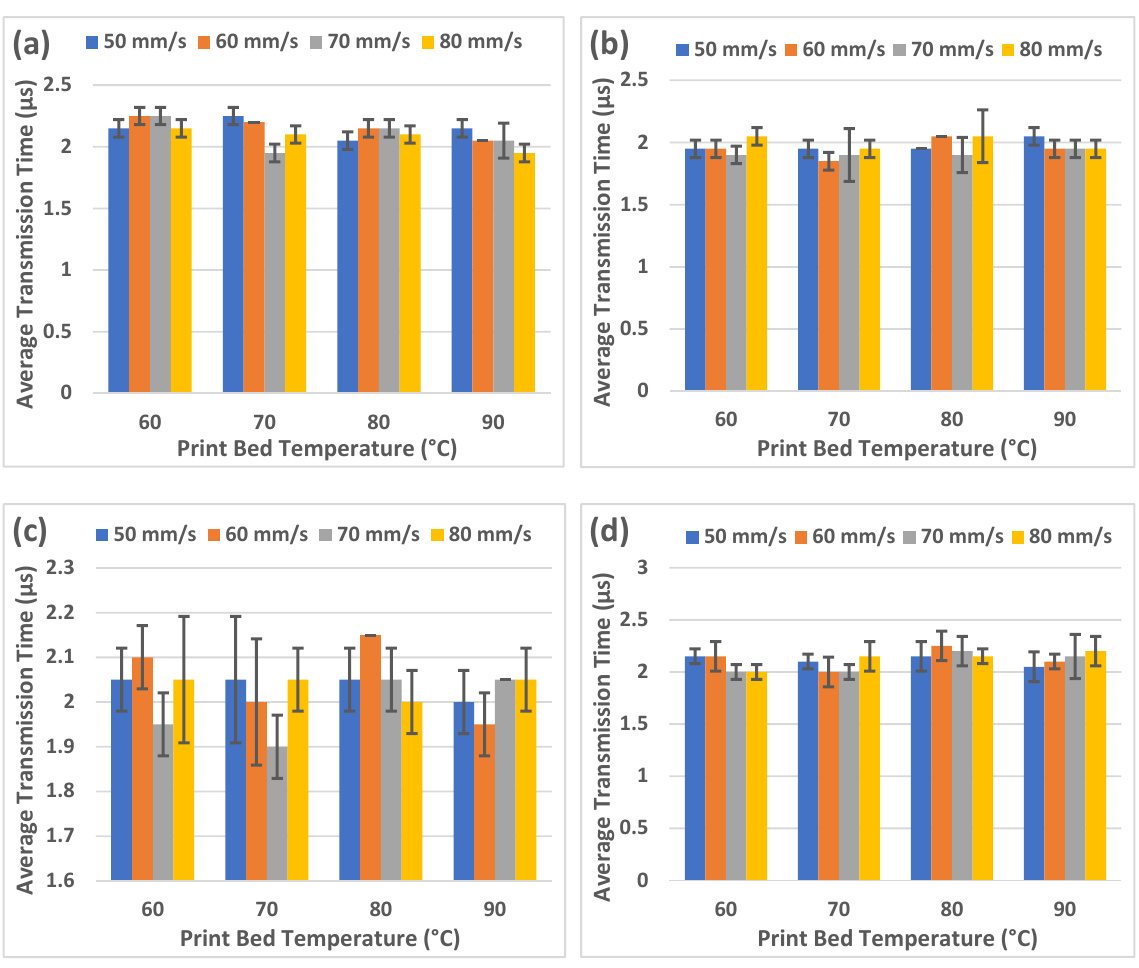
Figure 2. Results from ultrasonic testing at different nozzle temperatures: ( a ) 180 °C; ( b ) 190 °C; ( c ) 200 °C; ( d ) 210 °C.